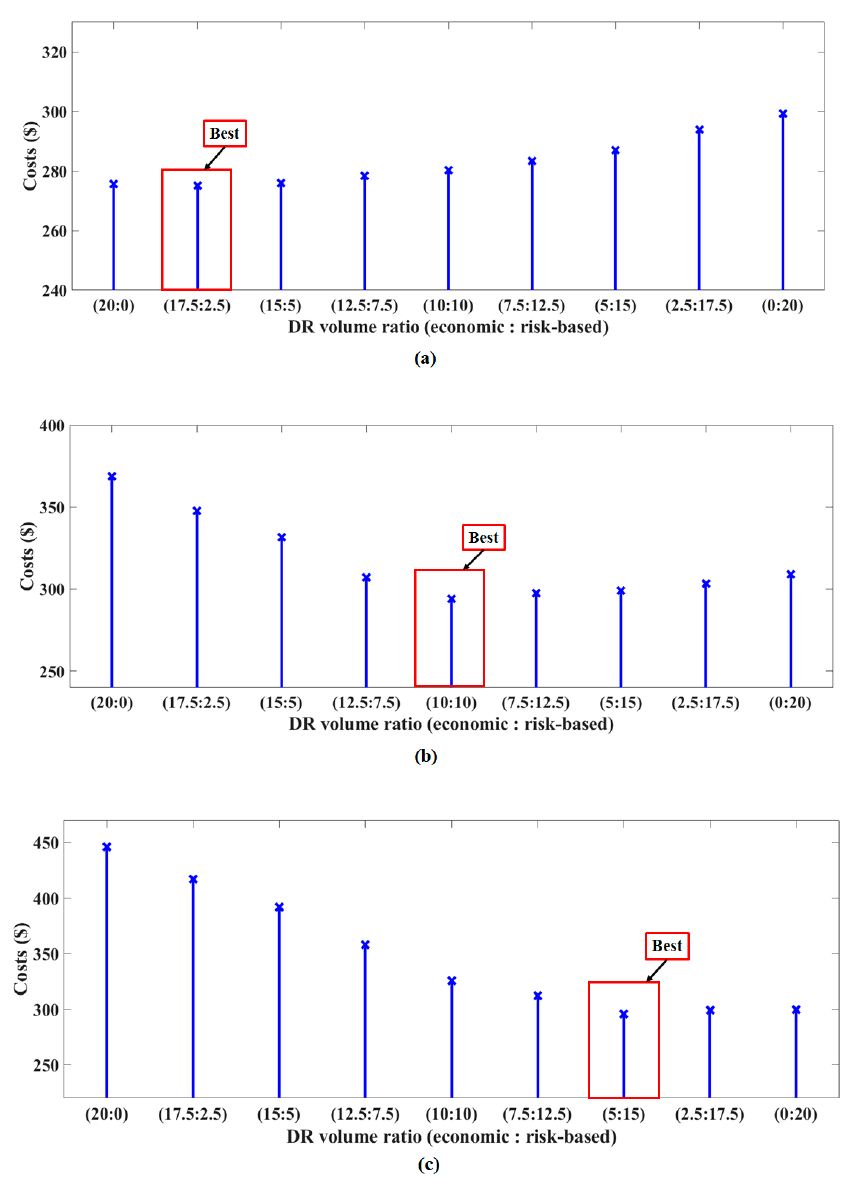
Figure 9. Risk-based operational cost as demand response (DR) volume ratio. ( a ) β = 0.1, ( b ) β = 0.5, and ( c ) β = 1.